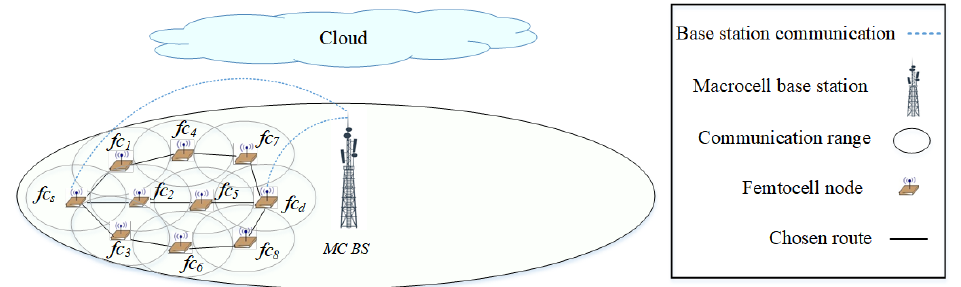
Figure 1. A multi-tiered 5G network. The source node fc s establishes a route to the destination node fc d . The optional routes are also shown.